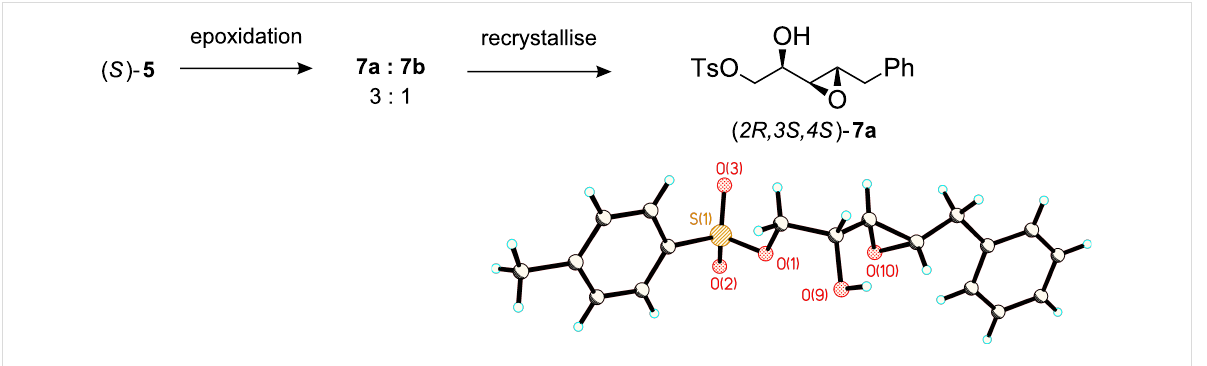
Figure 2: X-ray structure (CCDC 750306) and stereochemistry of α,β-epoxy alcohol 7a .